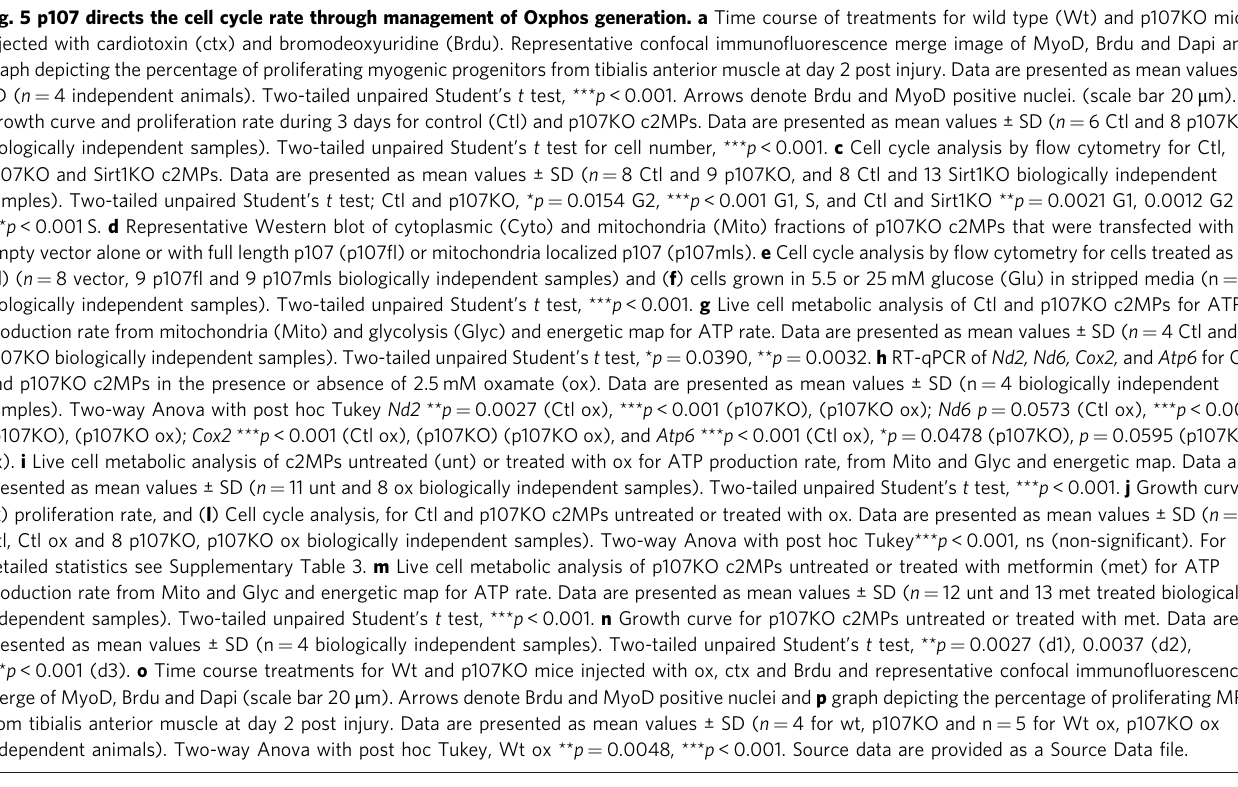
Fig. 5 p107 directs the cell cycle rate through management of Oxphos generation. a Time course of treatments for wild type (Wt) and p107KO mice injected with cardiotoxin (ctx) and bromodeoxyuridine (Brdu). Representative confocal immuno fl uorescence merge image of MyoD, Brdu and Dapi and graph depicting the percentage of proliferating myogenic progenitors from tibialis anterior muscle at day 2 post injury. Data are presented as mean values ± SD ( n = 4 independent animals). Two-tailed unpaired Student ’ s t test, *** p < 0.001. Arrows denote Brdu and MyoD positive nuclei. (scale bar 20 μ m). b Growth curve and proliferation rate during 3 days for control (Ctl) and p107KO c2MPs. Data are presented as mean values ± SD ( n = 6 Ctl and 8 p107KO